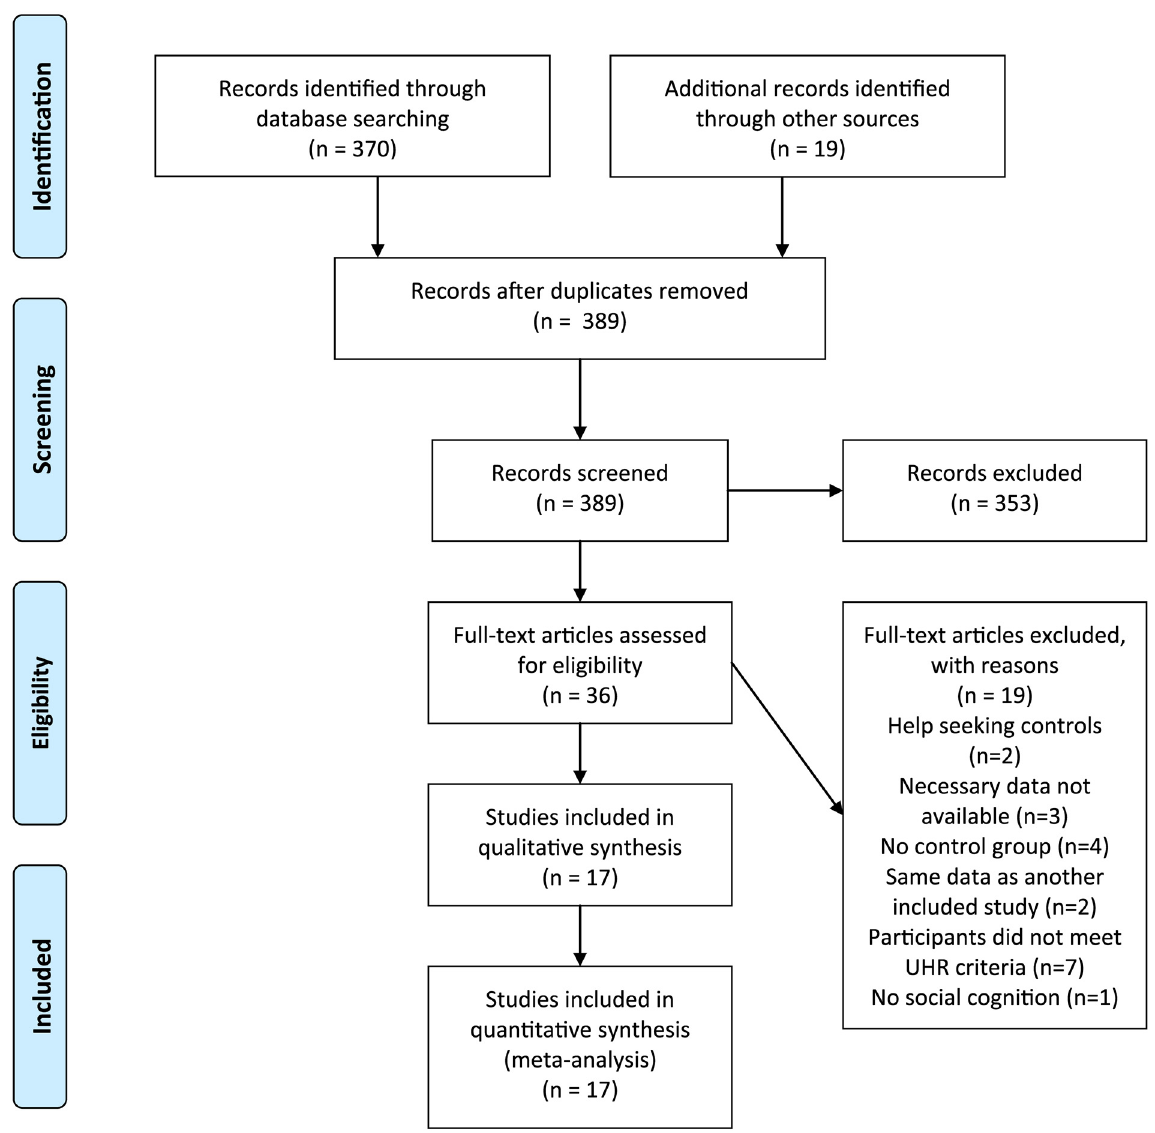
Fig 1. Flow diagram of the literature search. PRISMA flow diagram for meta-analysis of social cognition in individuals at ultra-high risk of psychosis. From : Moher D, Liberati A, Tetzlaff J, Altman DG, The PRISMA Group (2009). Preferred Reporting Items for Systematic Reviews and Meta-Analyses: The